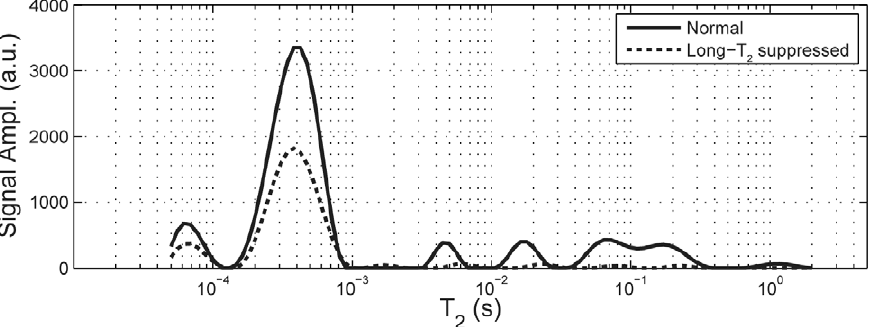
Figure 3. Solid line shows a the T 2 spectrum from a typical bone sample, and the dotted line shows the spectrum that results following the complex average of two signals, with and without an adiabatic full passage magnetization preparation. The total integrated signal from this long-T 2 suppressed spectrum is 95% from signals with T 2 , 1 ms, thereby demonstrating in principle a simple and practical method for generating a MRI contrast dominated by S A + S B